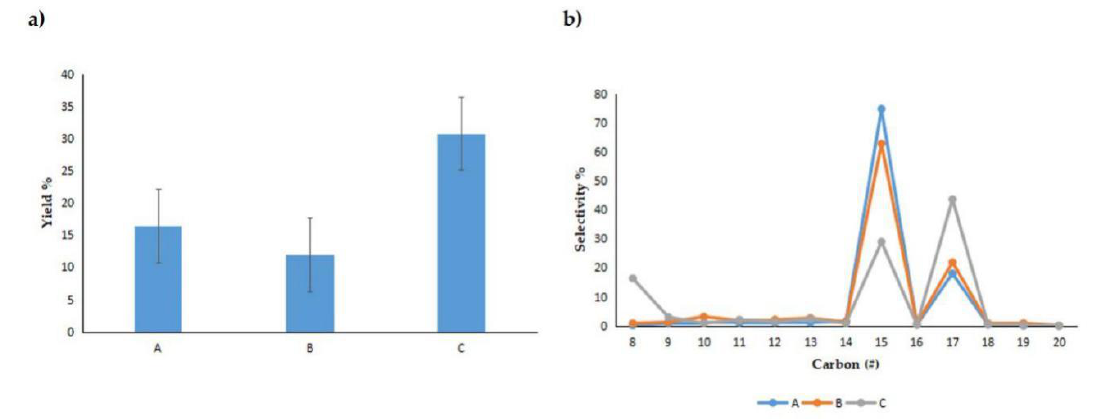
Figure 7. ( a ) Hydrocarbon yield %, ( b ) Distribution of deoxygenation (DO) liquid products of samples A, B, and C using Ni/Mo-AC.